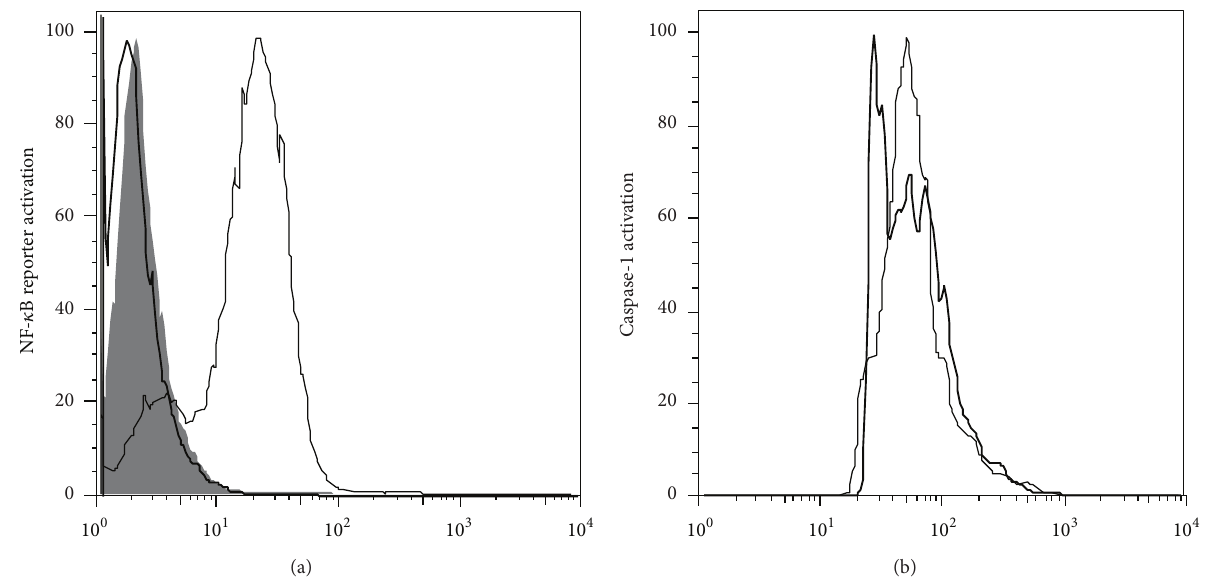
Figure 2: (a) NF- 𝜅 B reporter activation is suppressed by gambogic acid treatment. NF- 𝜅 B expression was measured by flow cytometry in a THP-1/NF- 𝜅 B reporter cell line incubated with gambogic acid and then stimulated for 24 h with E. coli . Each thin line in the histogram corresponds to untreated but E. coli stimulated cells, the shaded area corresponds to drug-treated and E. coli stimulated cells, and the thick line corresponds to untreated non-stimulated cells as a control. (b) Caspase-1 activation is decreased with gambogic acid treatment. Caspase-1 activation was measured using flow cytometry in a THP-1 cell line incubated with gambogic acid and then stimulated for 8h with E. coli . Each thin line in the histogram corresponds to untreated but E. coli stimulated cells used as control and the thick line corresponds to drug-treated and E. coli stimulated cells.